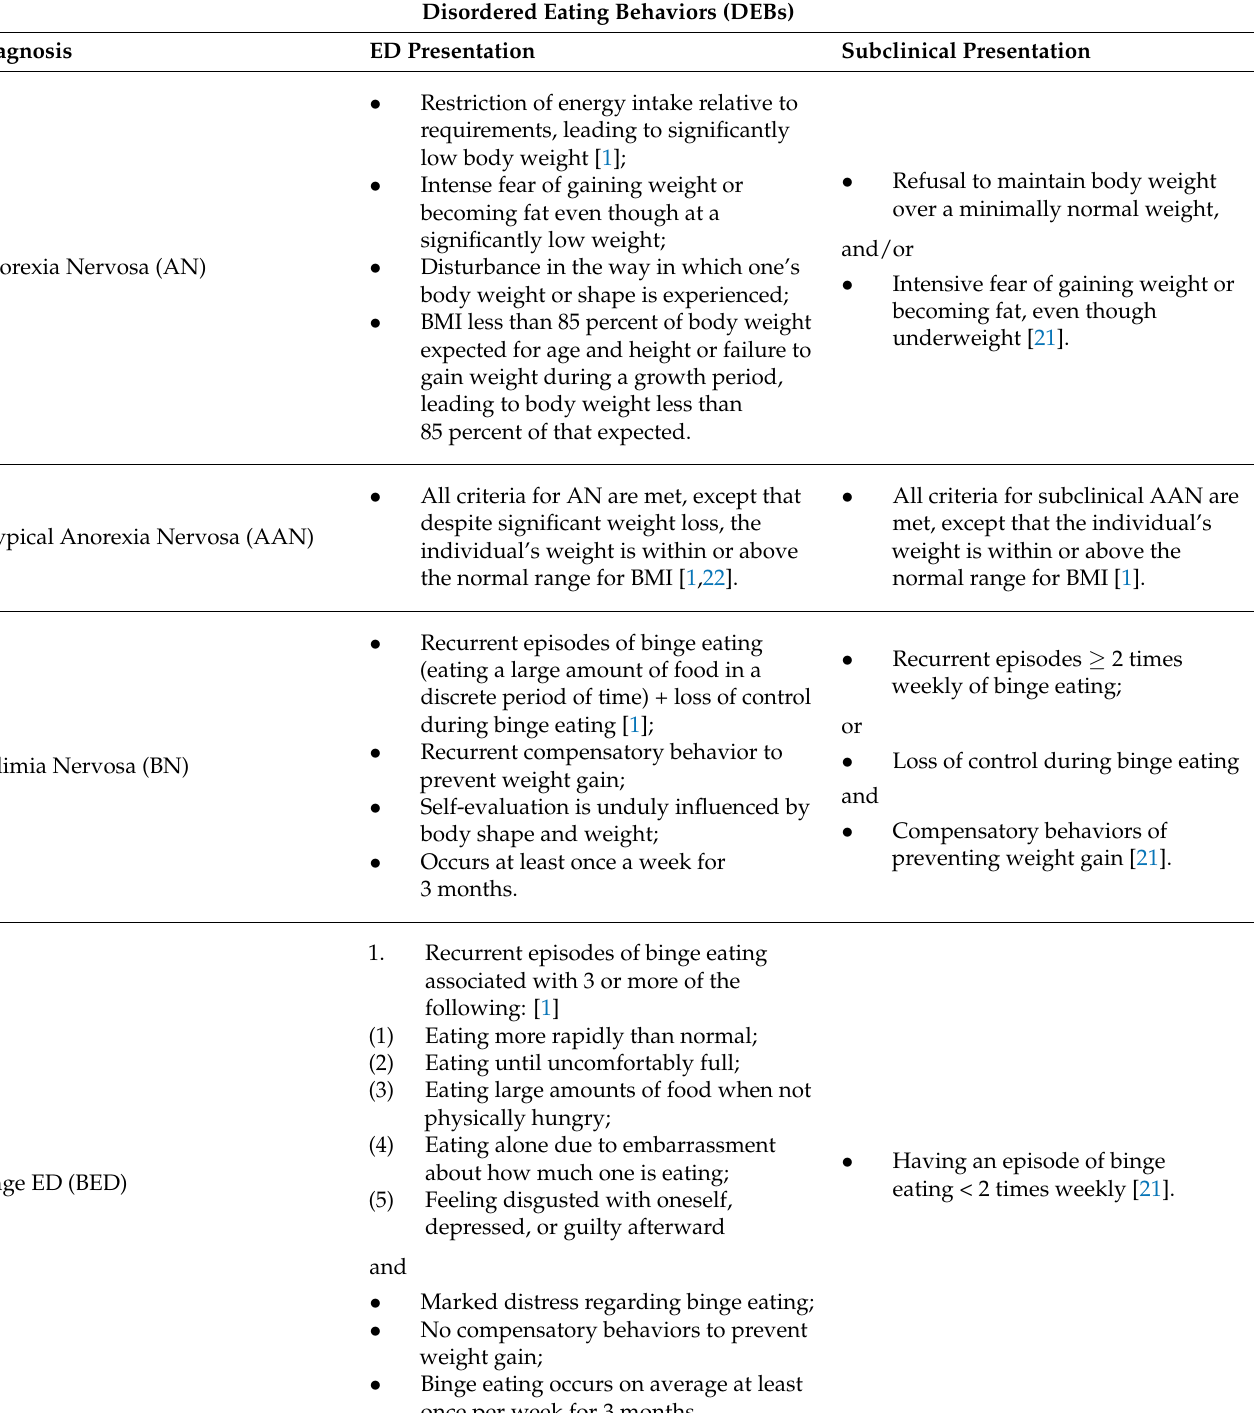
Table 1. Disordered Eating Behaviors